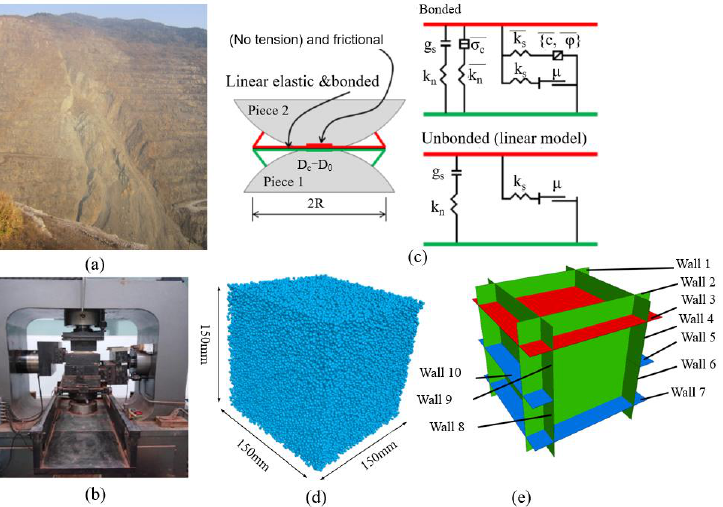
Figure 2. Concept of observing strain softening behavior tests and numerical modeling of slip zone soils at laboratory scale: ( a ) the slope with slip zone soil; ( b ) laboratory direct shear test; ( c ) linear Parallel Bond Model (Table 1 shows the meaning of the symbols of the parameters in the model); ( d ) numerical model of slip zone soil; ( e ) numerical model of walls for applying servo-control stress.